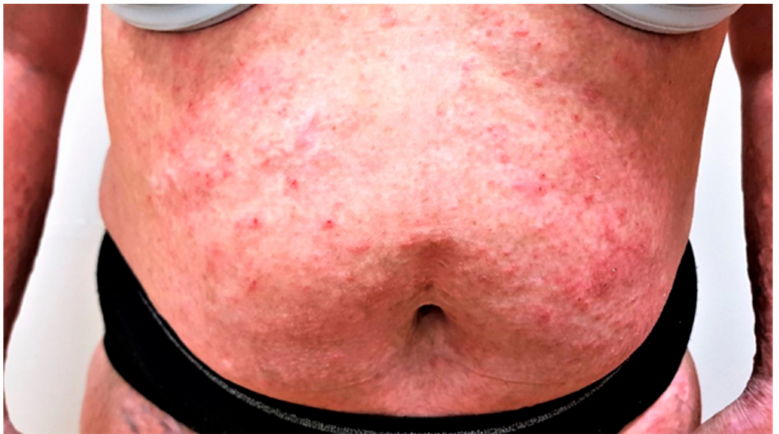
Figure 1. Patient before the initiation of dupilumab with EASI score of 50.